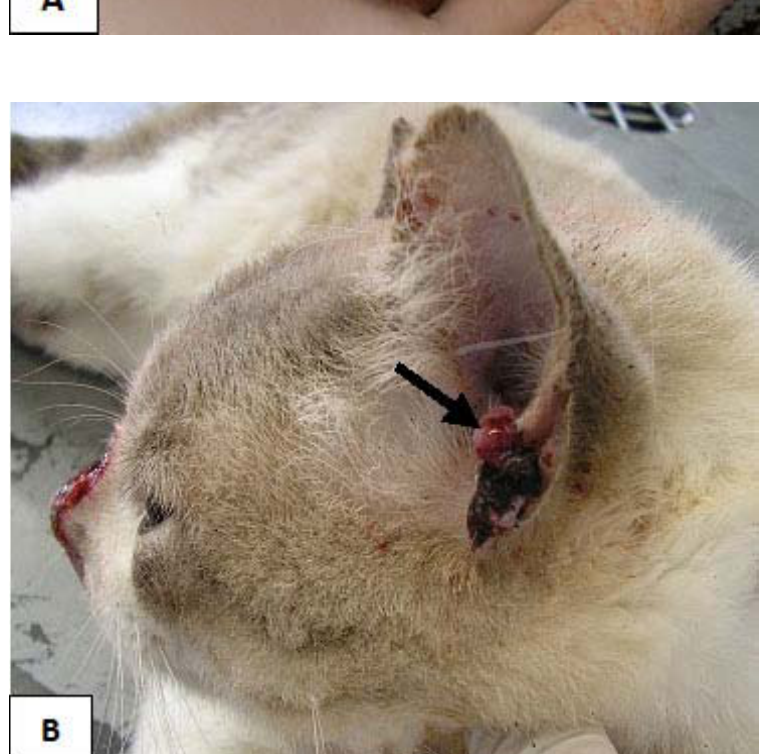
Figure 1. Cutaneous leishmaniasis in a feline infected with Leishmania (Leishmania) amazonensis ; ( A ) ulcerated lesion on the nose and ( B ) nodules on the ear